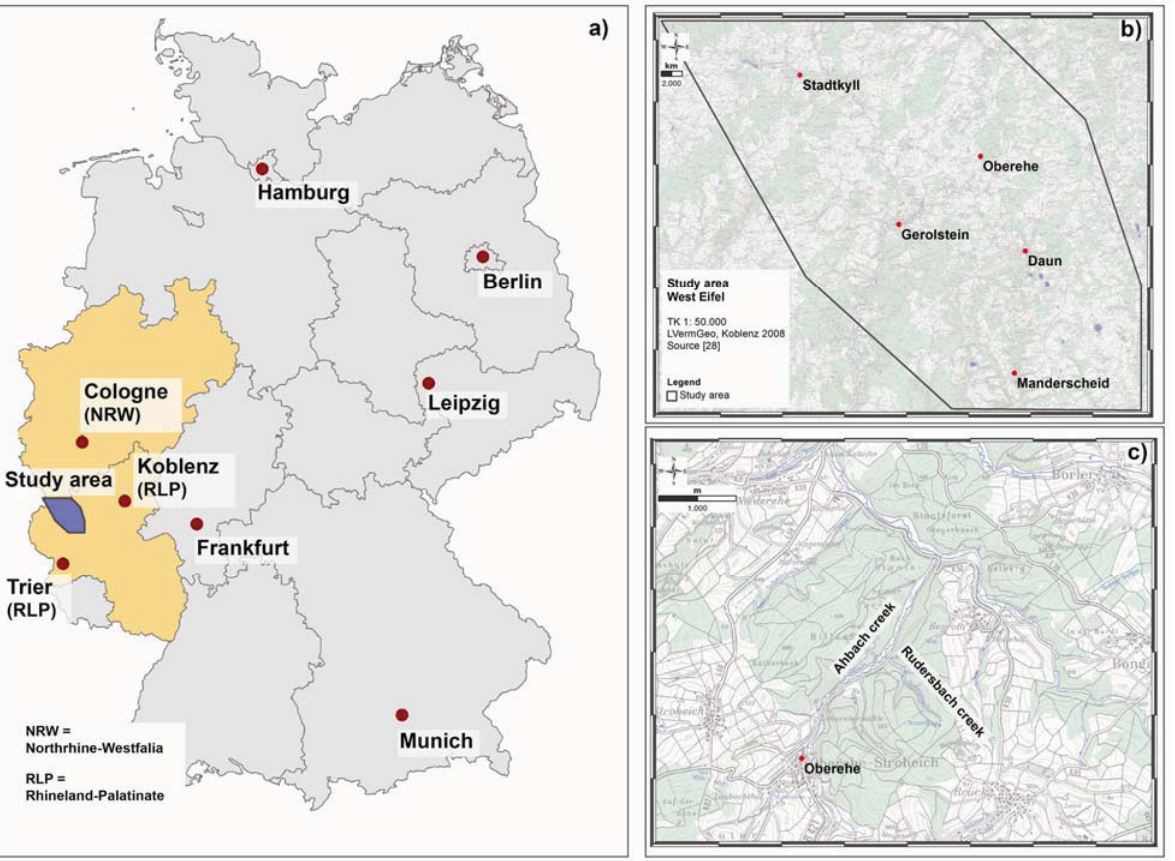
Figure 1. Position of the 1,140 km² study area within Germany ( a ), locations of the study area within the West Eifel ( b ) and the reference location Oberehe ( c